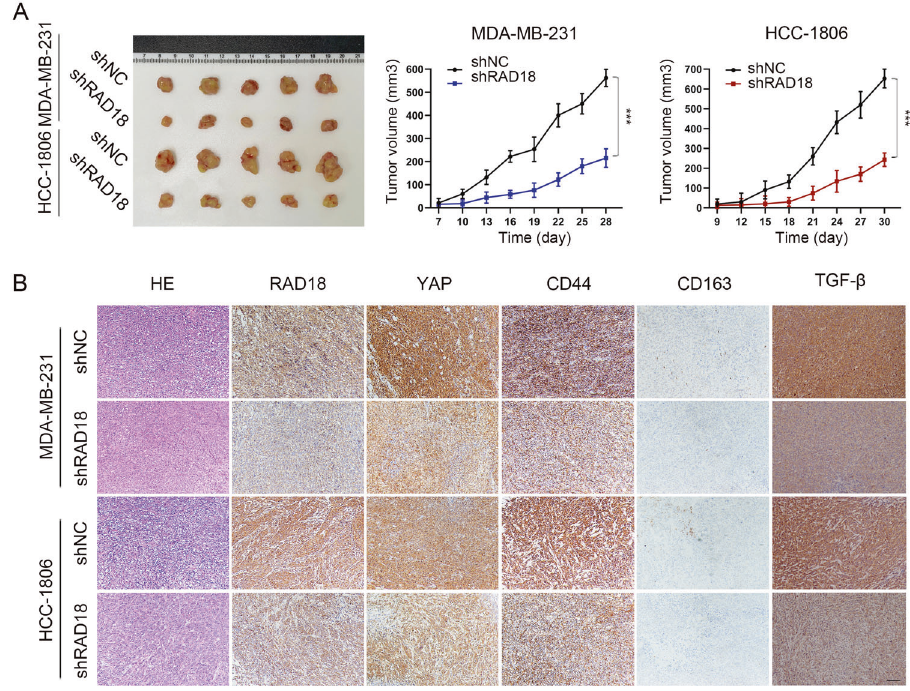
Fig. 6 In nude mice xenografts, RAD18 promoted tumor progress and M2 polarization. A After 4 weeks, the tumors of nude mice were removed and evaluated by HE staining. Images of dissected xenografted tumors implanted subcutaneously with TNBC cells (shNC/shRAD18 MDA-MB-231 and shNC/shRAD18 HCC-1806) were showed. Tumor growth curves determined by caliper measurements shown as mean (mm 3 ) ± SD. n = 5/group. B H&E and IHC staining of RAD18, YAP, CD44, CD163, and TGF β in nude mice xenografts tumor samples.